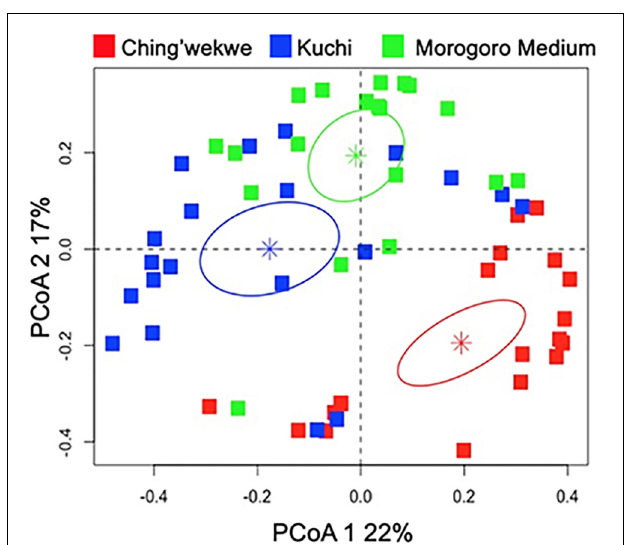
FIGURE 3 | Principal coordinate analysis of the gene expression profiles of the three ecotypes. The PCoA plot demonstrates significant clustering of each ecotype independently ( p -value < 0.01). The Ching’wekwe is represented by the red squares, the Kuchi by blue and Morogoro Medium by green. The stars represent the average for each ecotype and the ellipse is the 95% confidence interval (in each respective